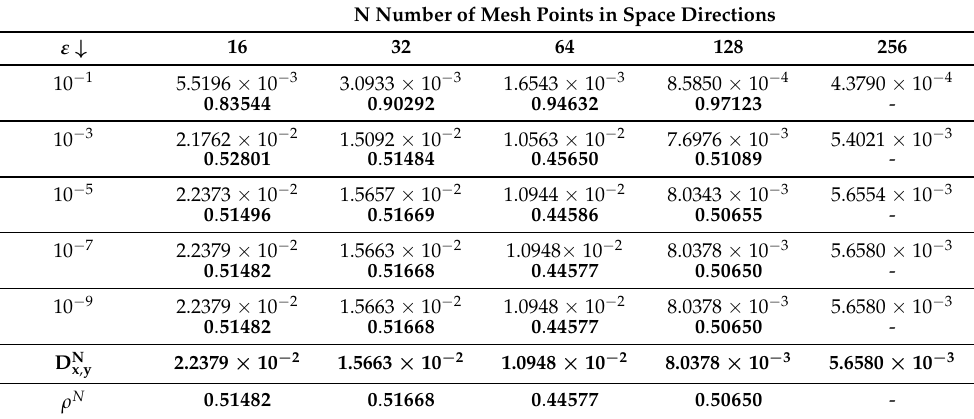
Table 1. Maximum error and order of convergence for the Example 1 with M = 2 7